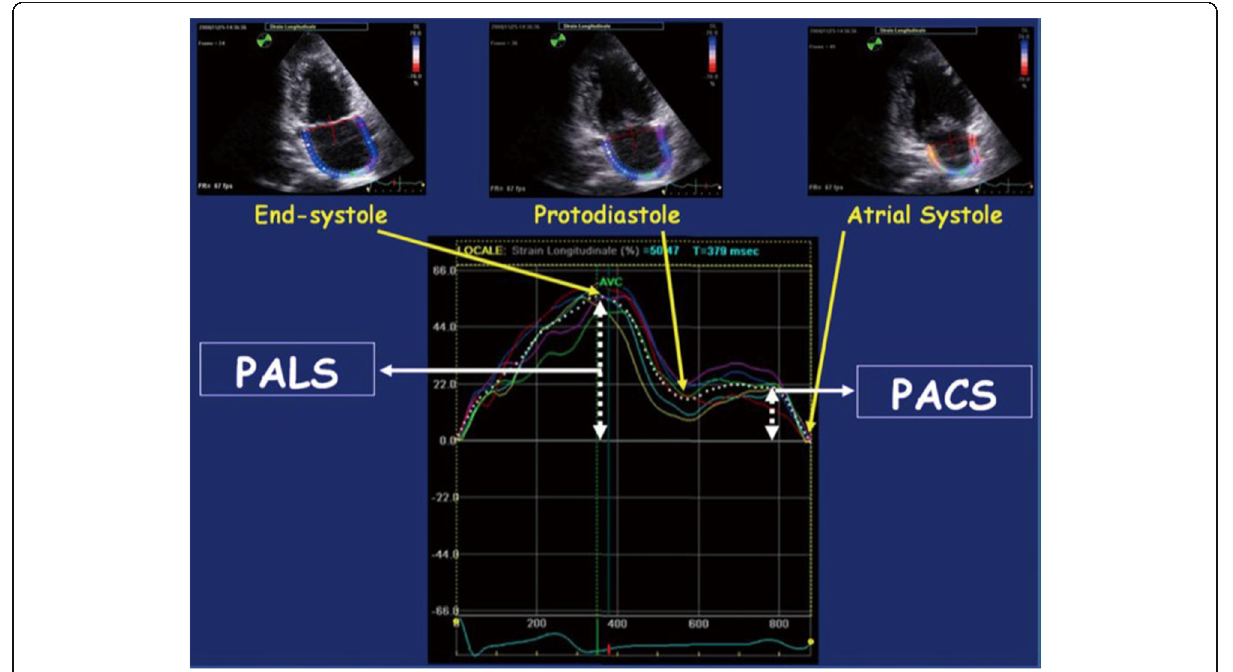
Fig. 2 Peak atrial longitudinal strain (PALS) and peak atrial contraction strain (PACS). Modified from Cameli et al.